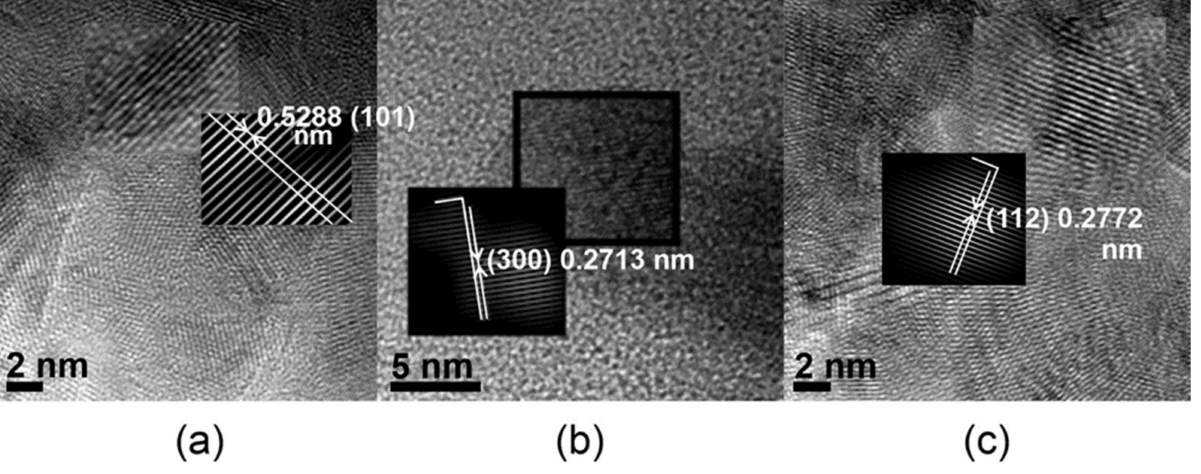
Figure 7. HRTEM images for specimens: ( a ) Bio-Oss (inset, inverse fast Fourier transform); ( b ) Gen-Os (inset, inverse fast Fourier transform); ( c ) HA1 (inset, inverse fast Fourier